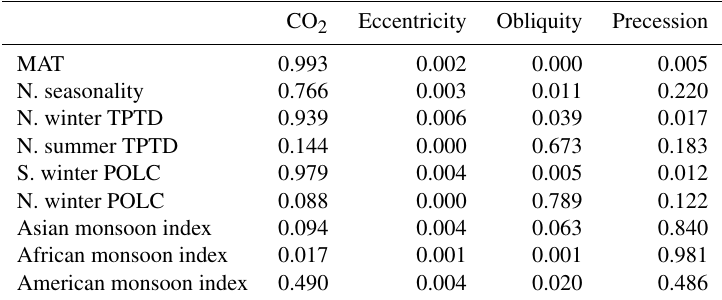
Figure 5. Correlation between three forcing factors (CO 2 , obliquity and precession index; in columns from left to right) and the simple metrics (MAT, northern seasonality, northern winter tropical–polar temperature difference and northern summer tropical–polar temperature difference; in rows from top to bottom). CO 2 is plotted in colour in the obliquity and precession plots (blue is low; red is high). Table 4. Total effects of forcing parameters on simple scalar metrics. POLC indicates polar